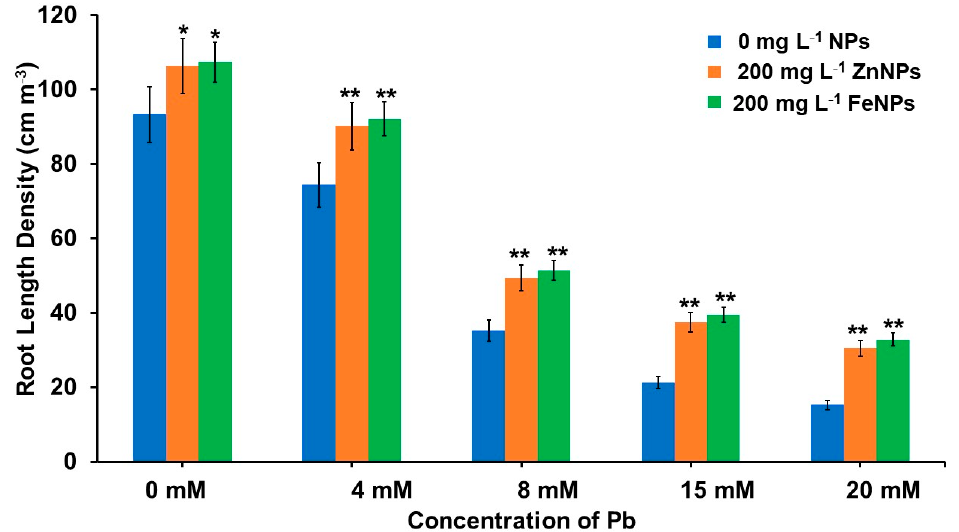
Figure 3. Effects of Pb and nanoparticles (ZnNPs and FeNPs) on root length density of 20-day-old B. alba seedling. Error bars representing the standard error. Asterisks above the error bars denote significant differences between treatments in comparison to respective treatment without NPs (* = p value < 0.05 and ** = p value < 0.01, Duncan’s Multiple Range Test).